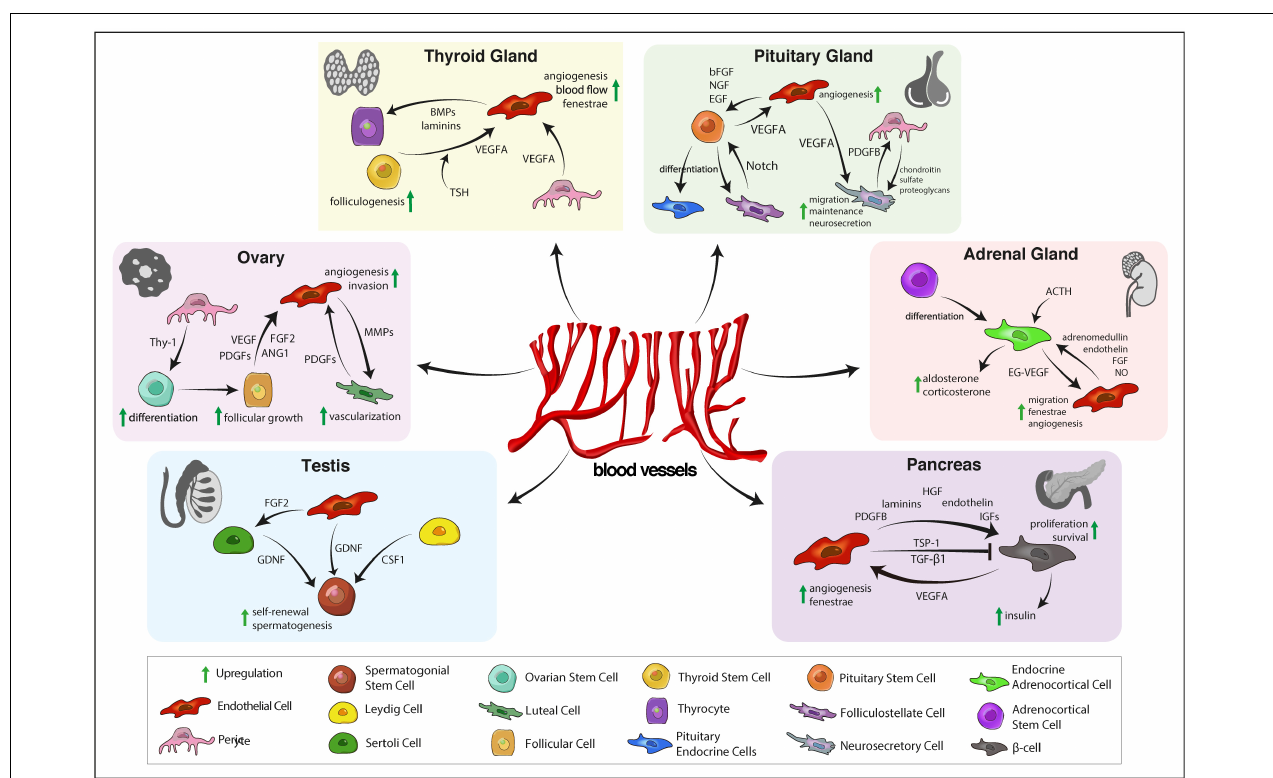
FIGURE 1 | Vascular niche functions in the endocrine system. In the testis, ECs release various endocrine signals to maintain SSCs and spermatogenesis. OSC maintenance is supported by pericytes. During follicular and luteal stages of the cycle, growth factors regulate periodic growth and regression of ovarian vasculature that is needed for follicular and luteal development. In the thyroid, angiogenic signals from TSCs and pericytes regulate angiogenesis, endothelial fenestrae formation that is important for thyrocyte function. Pituitary ECs and pericytes promote maintenance and function of neurosecretory cells in the neurohypohysis and pituitary stem cells in the adenohypophysis. Angiocrine signals also regulate endocrine function of the adrenal cortex, that, in turn, promotes angiogenesis via the endocrine gland-specific growth factor EG-VEGF. In the pancreas, reciprocal interaction between ECs and β -cells is required for angiogenesis and insulin secretion. EC, endothelial cell; SSC, spermatogonial stem cell; FGF2, fibroblast growth factor 2; GDNF, glial cell line-derived neurotrophic factor; CSF-1, colony-stimulating factor 1; OSC, ovarian stem cell; PDGF, platelet-derived growth factor, VEGF, vascular endothelial growth factor; ANG1, angiopoietin 1; MMP, matrix metalloproteinase; TSC, thyroid stem cell; TSH, thyrotropin-releasing hormone; BMP, bone morphogenetic protein; bFGF, basic fibroblast growth factor; NGF, nerve growth factor; EGF, epidermal growth factor; EG-VEGF, endocrine gland-derived vascular endothelial growth factor; NO, nitric oxide; HGF, hepatocyte growth factor; IGF, insulin-like growth factor; TSP-1, thrombospondin-1; TGF- β 1, transforming growth factor β